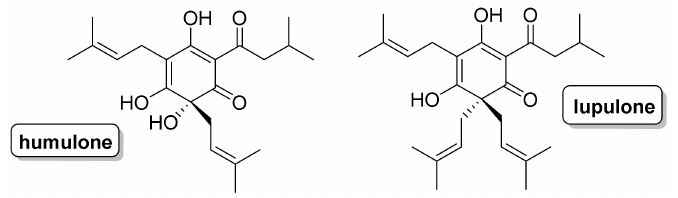
Figure 1. Structures of ( − )-humulone and